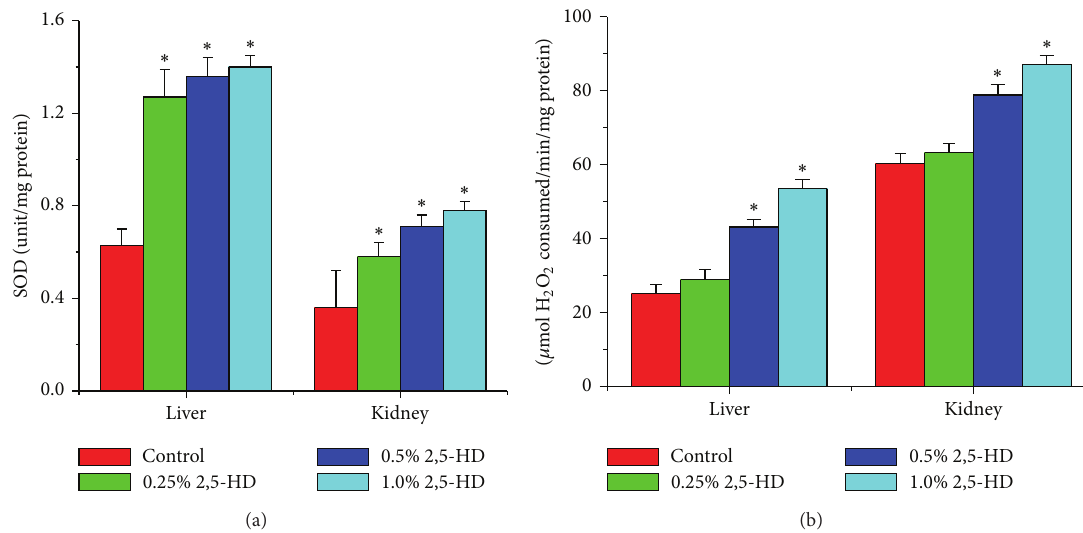
Figure 1: Comparison of hepatic and renal SOD and CAT activities among the control and treated rats ( 𝑁 = 8 ). Values represent mean ± SD of enzyme activity (unit/mg protein of tissue). Asterisk indicates statistical difference from control ( 𝑃 < 0.05 ).